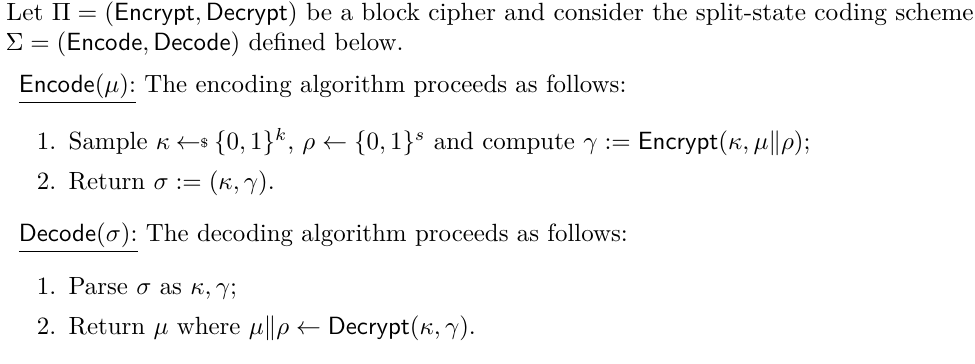
Figure 1: Description of our non-malleable